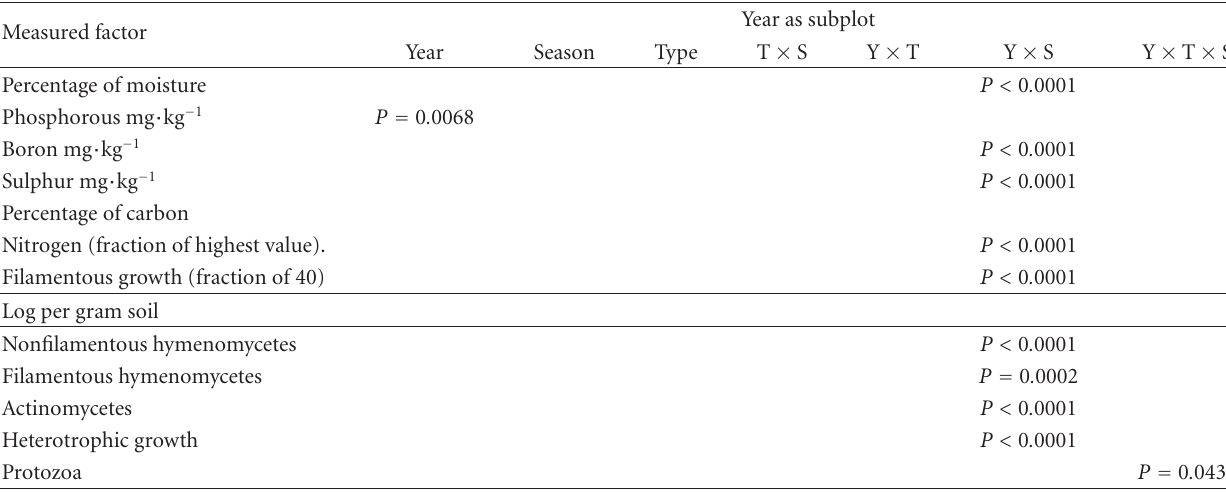
Table 2: ANOVA table with year included as a subplot. Significant e ff ects indicated by P values for all